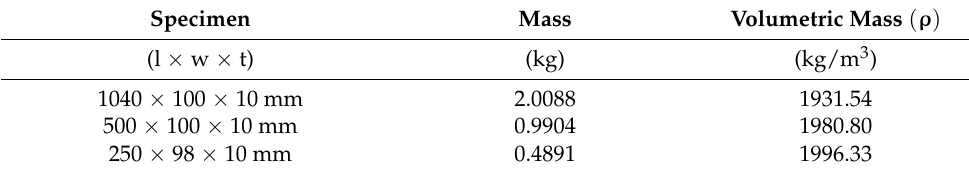
Figure 4. Geometry of GFRP specimens (dimensions in mm). Table 1. Mass and density of GFRP